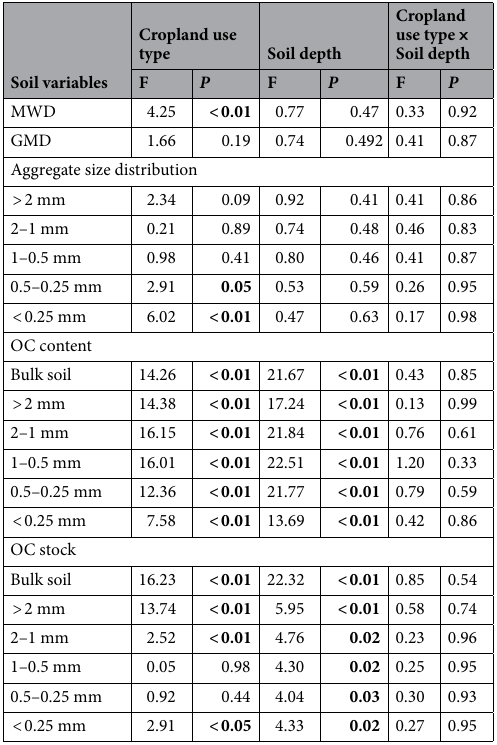
Table 1. The two-way ANOVA results for all variables. Bold values were significant at p < 0.05. MWD: mean weight diameter. GWD: geometric mean diameter. Significant values are in